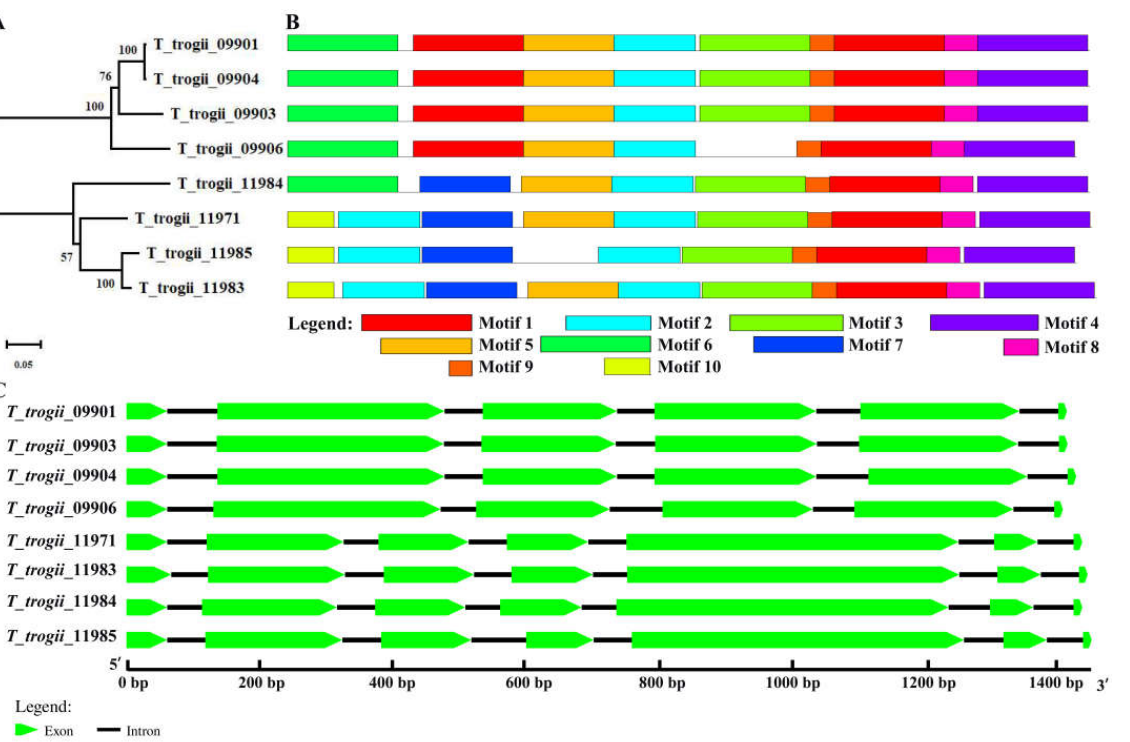
Figure 2. Phylogenetic analysis ( A ), conserved motifs ( B ), and exon–intron structure ( C ) of TtMnP gene family members.